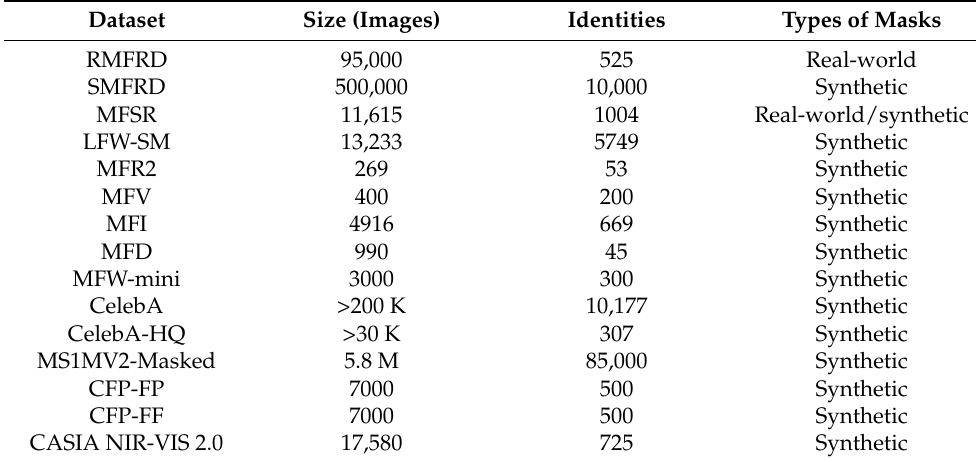
Table 2. Summary of the common MFR benchmarking